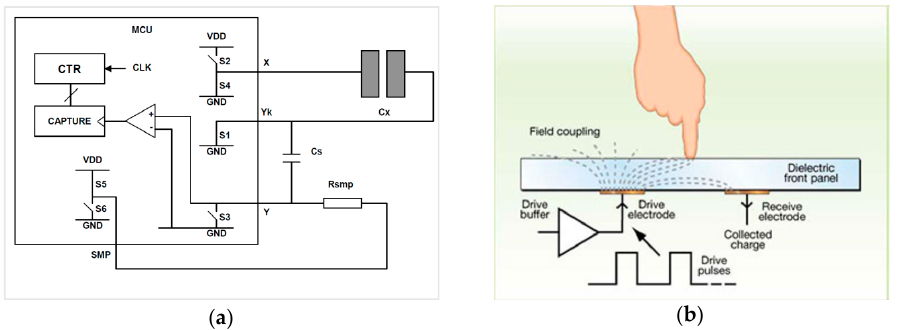
Figure 2. ( a ) The equivalent circuit in measurement phase [17]; ( b ) field coupling between electrodes. Dielectric front panel is FR4 PCB in the study. In products, usually, a glass is also put on the printed circuit board (PCB).